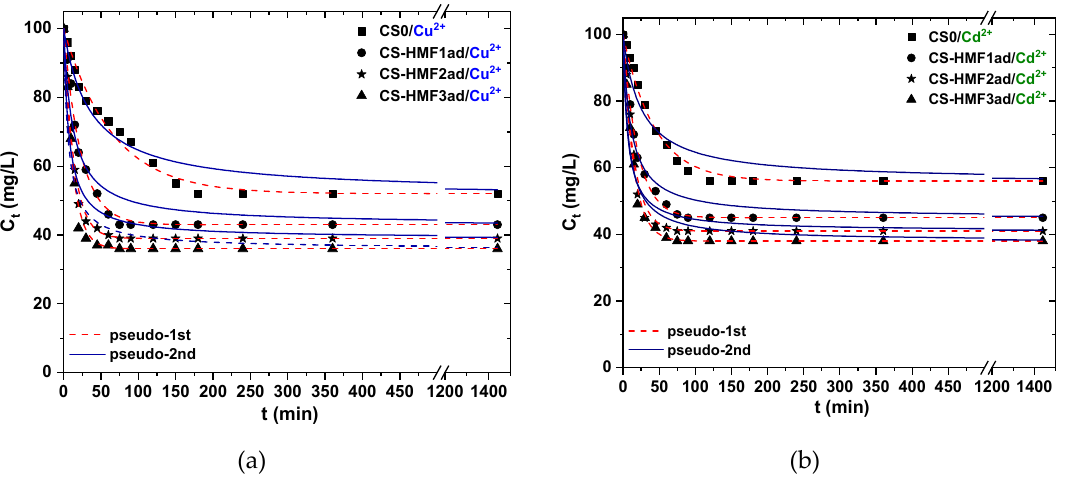
Figure 8. Kinetic data for the removal of (a) Cu 2+ and (b) Cd 2+ by CS0, CS-HMF1ad, CS-HMF2ad, CS-HMF3ad. Fitting to PS1 and PS2 equations. Experimental conditions: C 0 =100 mg/L, V =20 mL, N =160 rpm, T =25 °C, pH=5, m =0.02 g.